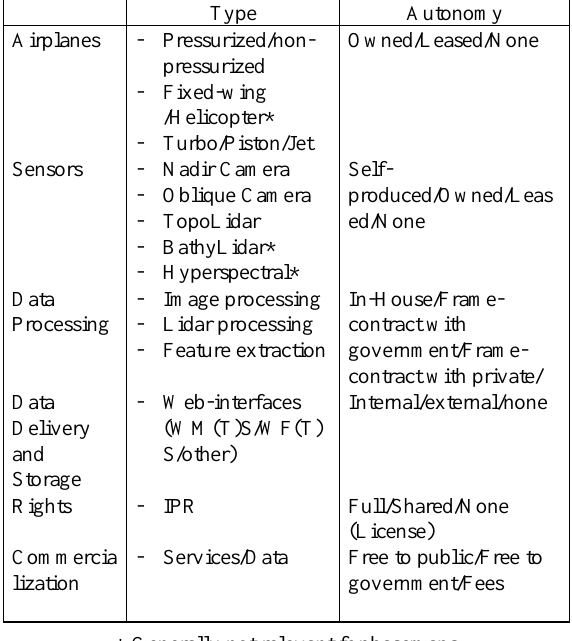
Table 1 . NMCA Autonomy in Basemap